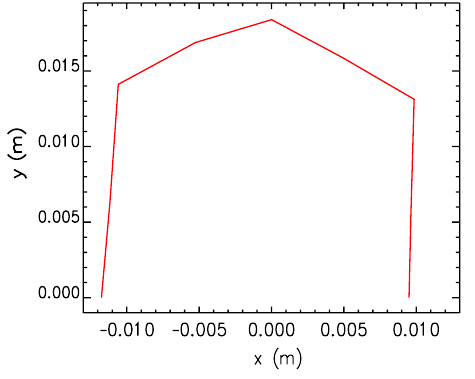
FIG. 14. Dynamic aperture in the ( y (cid:1) x ) space at the entrance into one of the CCBs for the on-momentum particle.